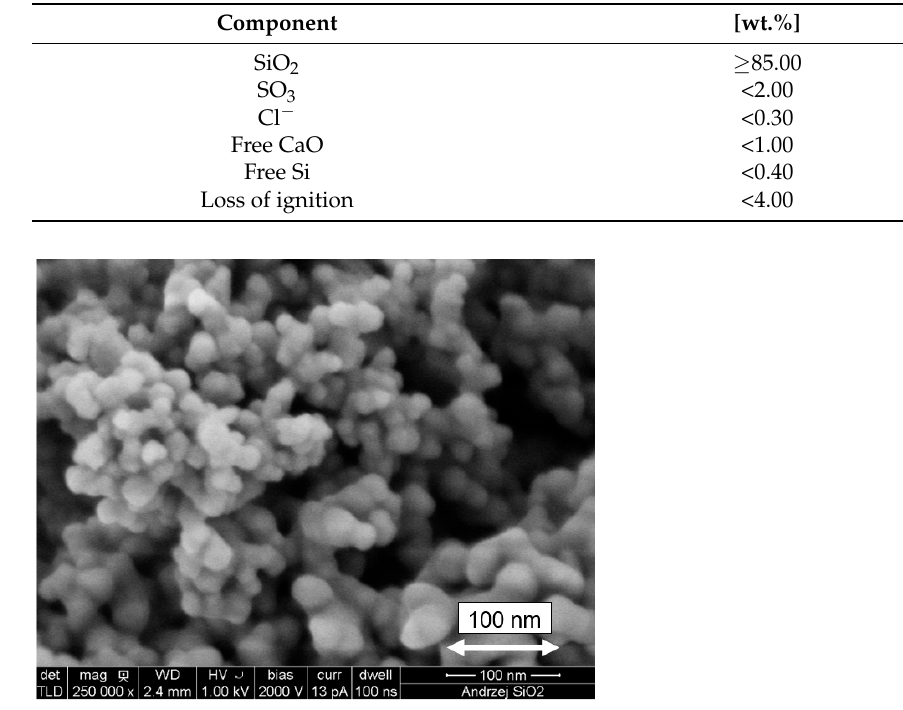
Figure 2. SEM image of SiO 2 nanoparticles.